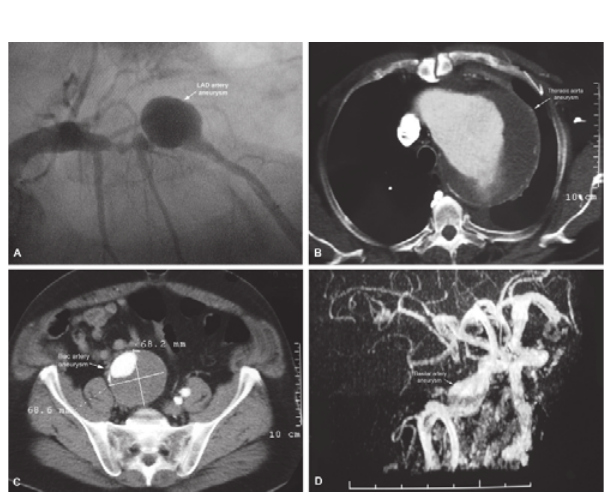
Figure 1 - A - Coronary angiography of left anterior descending coronary artery aneurysm. B - CT angiogram of descending thoracic aorta aneurysm. C - CT angiogram of right iliac artery aneurysm. D - Cerebral angioresonance of basilar artery